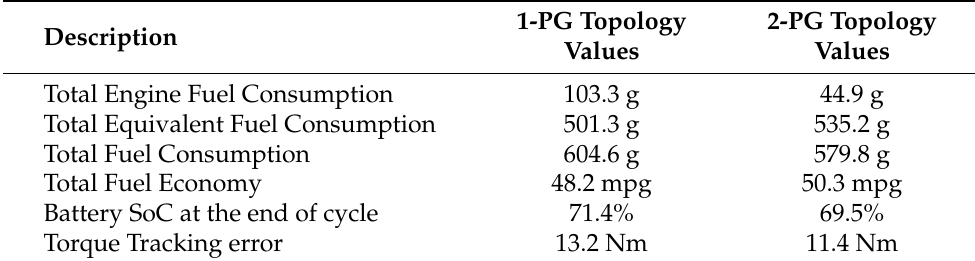
Table 3. Summary of simulation results of the 1-PG and 2-PG topologies over the US06.